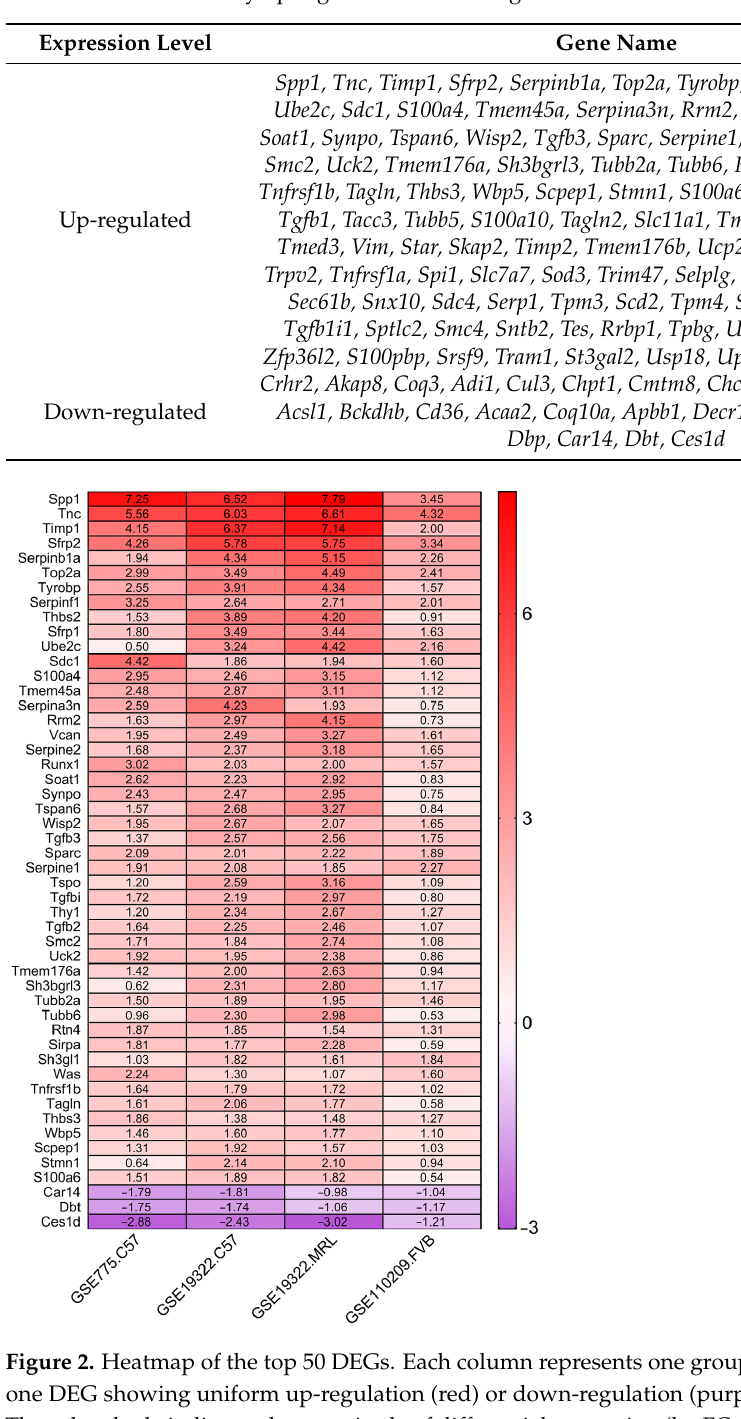
Table 3. Genes uniformly up-regulated or down-regulated across strains following AMI.